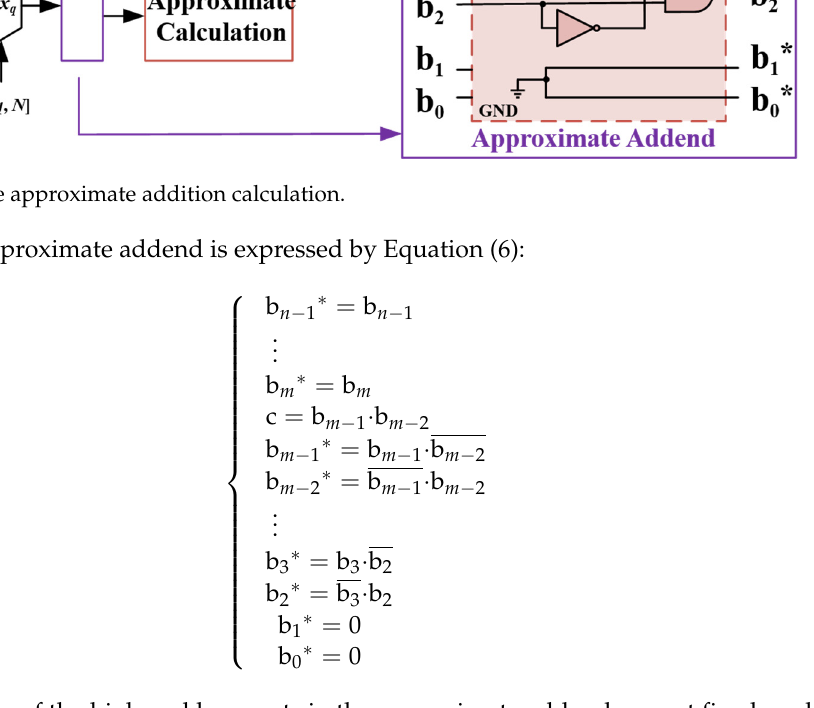
Table 2. The approximate addend and corresponding error.